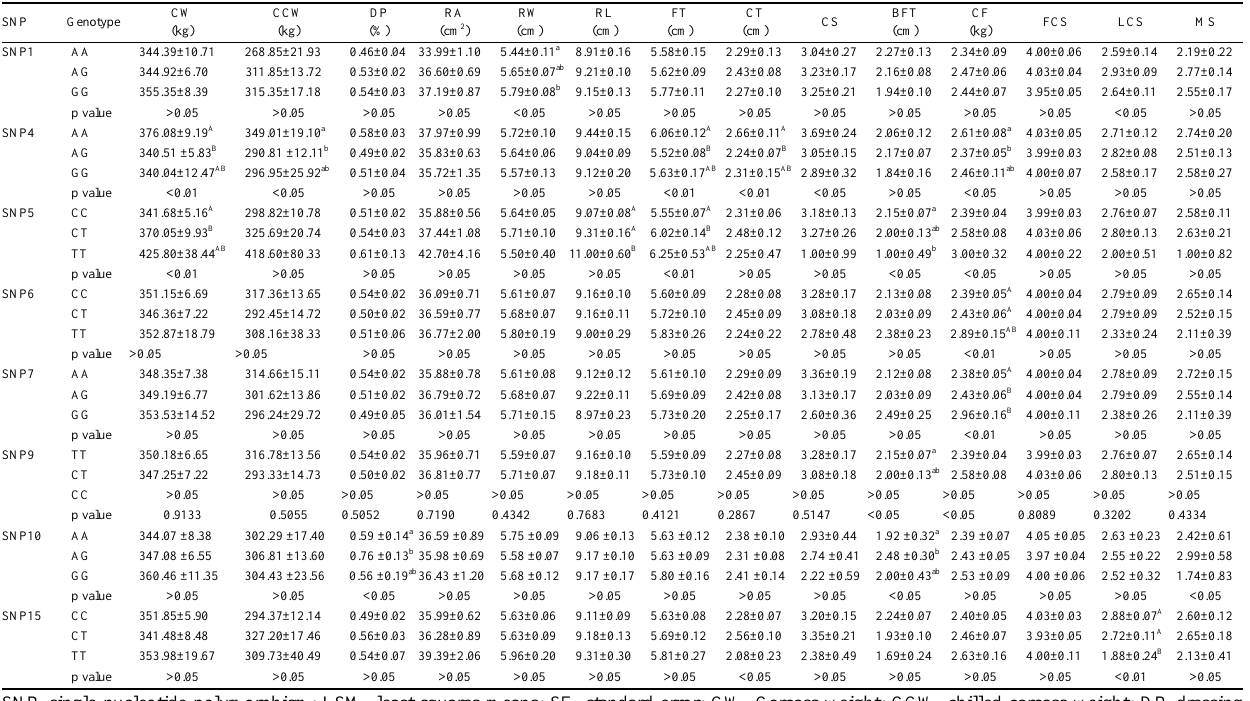
Table 4. Significant association analysis between SNP effects and meat quality traits in Snow Dragon beef population (LSM±SE)* SNP